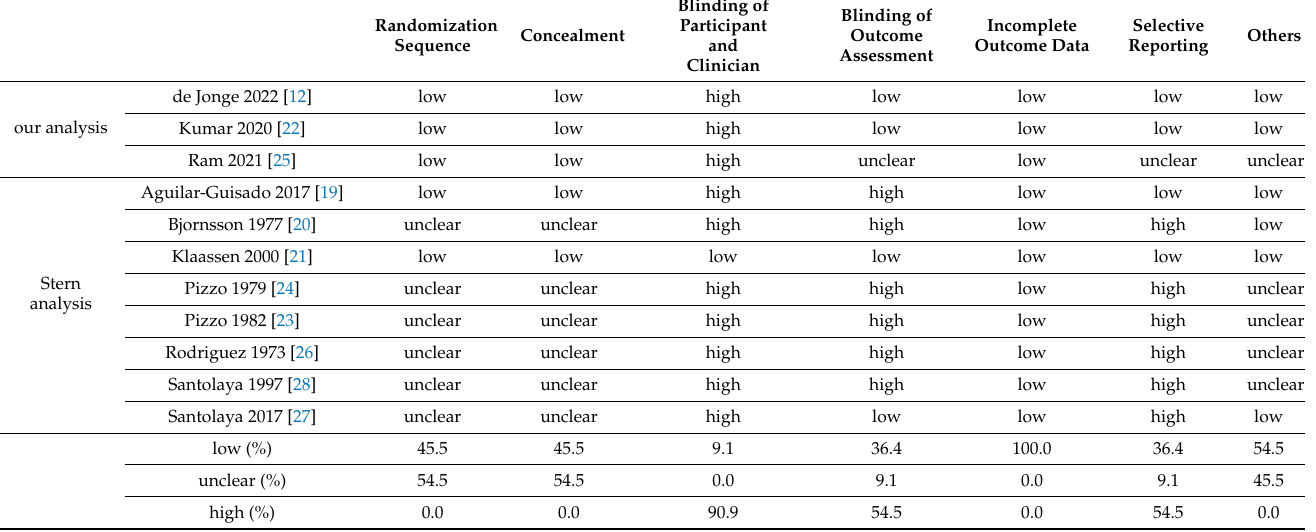
Table 2. Summary of risk of bias in all the randomized controlled trials including the results reported by de Jonge et al. [12], Ram et al. [25], and Kumar et al. [22], and the results of the systematic review by Stern et al. [13]. The risk of bias included randomization sequence, concealment, blinding of participant and clinician, incomplete outcome data, selective reporting, and others. The color of risk of bias: green, low risk of bias; yellow, unclear risk of bias; red, high risk of bias. Blinding of Blinding of Randomization Participant Incomplete Selective Outcome Sequence Concealment and Outcome Data Reporting Others Assessment Clinician